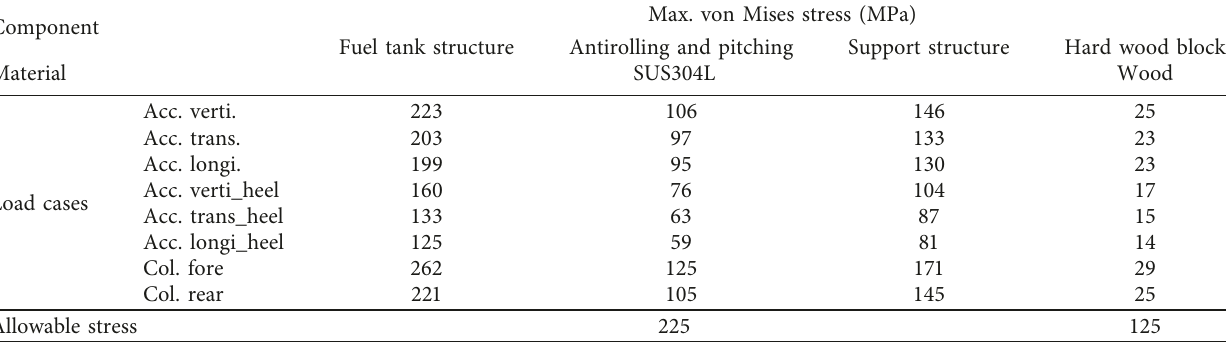
Table 7: Structural analysis results according to each load case.